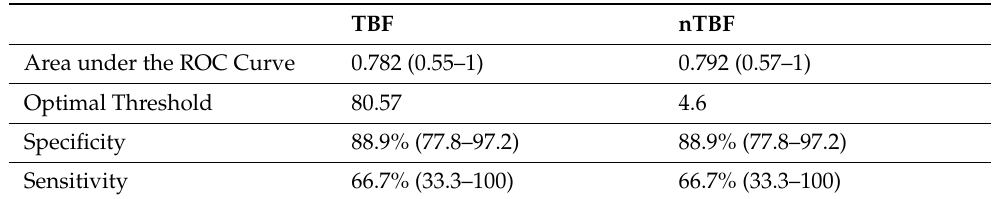
Table 4. ROC-analysis data comparing maximum TBF and maximum nTBF in groups of wildtype and IDH1-mutant